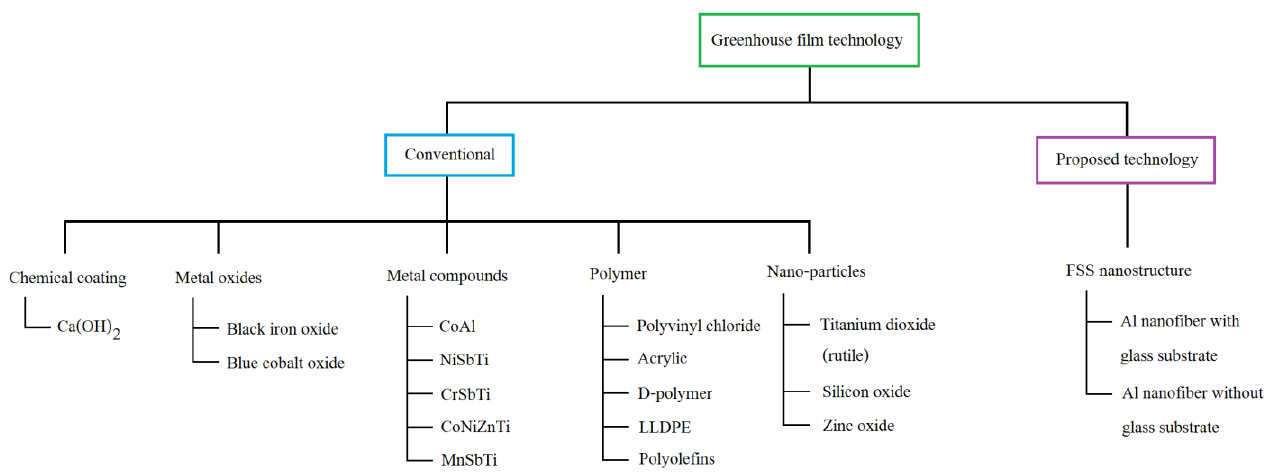
Figure 1. Greenhouse covering film technology.